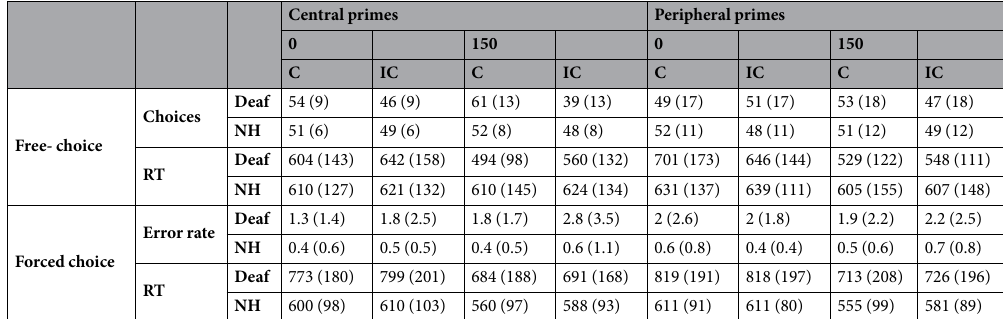
Table 2. Descriptive Statistics - Experiment 2. Note: Mean values with SD in brackets. C: Congruent, IC: Incongruent, NH: Normal-hearing, “0” and “150” refer to mask-target SOA in ms, Choices and error rates are given in percentage (%). RT is given in